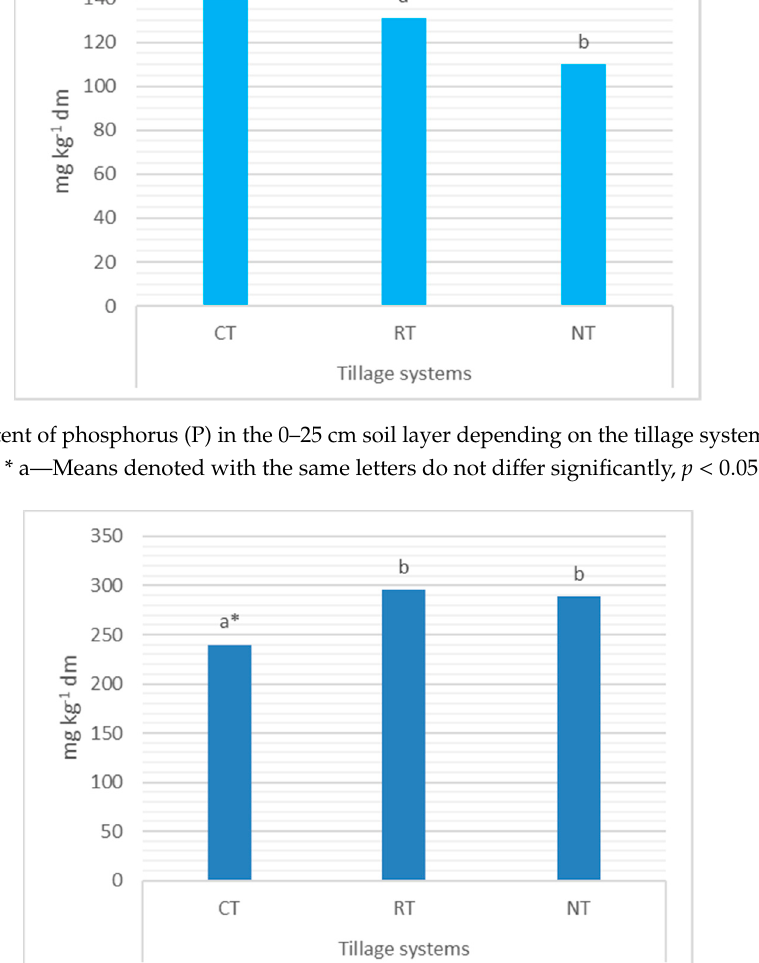
Figure 9. Content of potassium (K) in the 0–25 cm soil layer depending on the tillage system (average of 2014–2016). * a—Means denoted with the same letters do not differ significantly, p < 0.05.